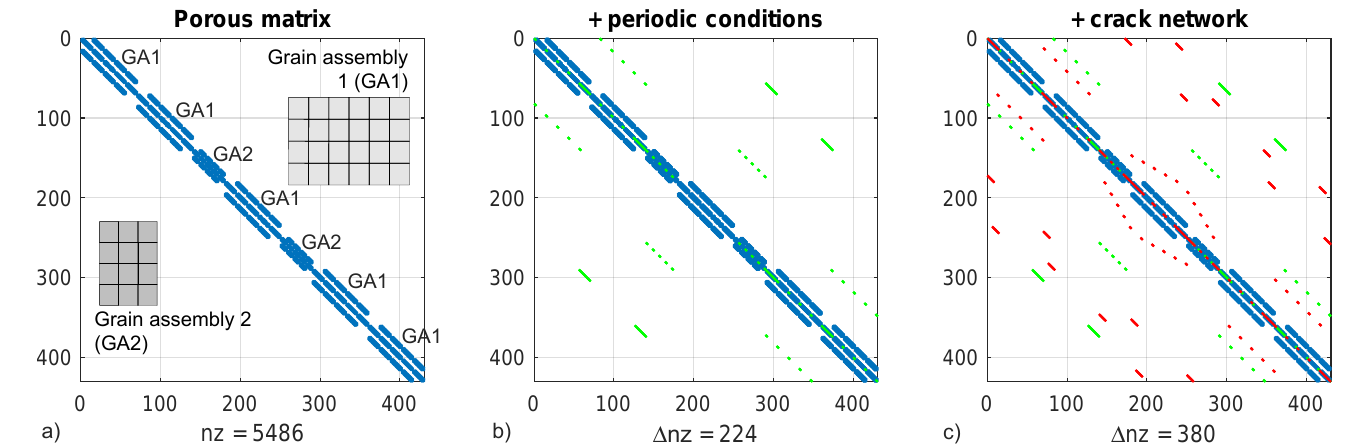
Figure 2. Assembly of the matrix grains in the global stiffness matrix, five grain type 1 assemblies (GA1) and two grain type 2 assemblies (GA2) ( a ). Assembly of periodic boundary conditions and kinematic restrictions by penalization causing a large increase of matrix bandwidth ( b ). Crack network assembly ( c ). Where nz is the non-zero count and ∆ nz the increase of non-zero count by periodic conditions and crack